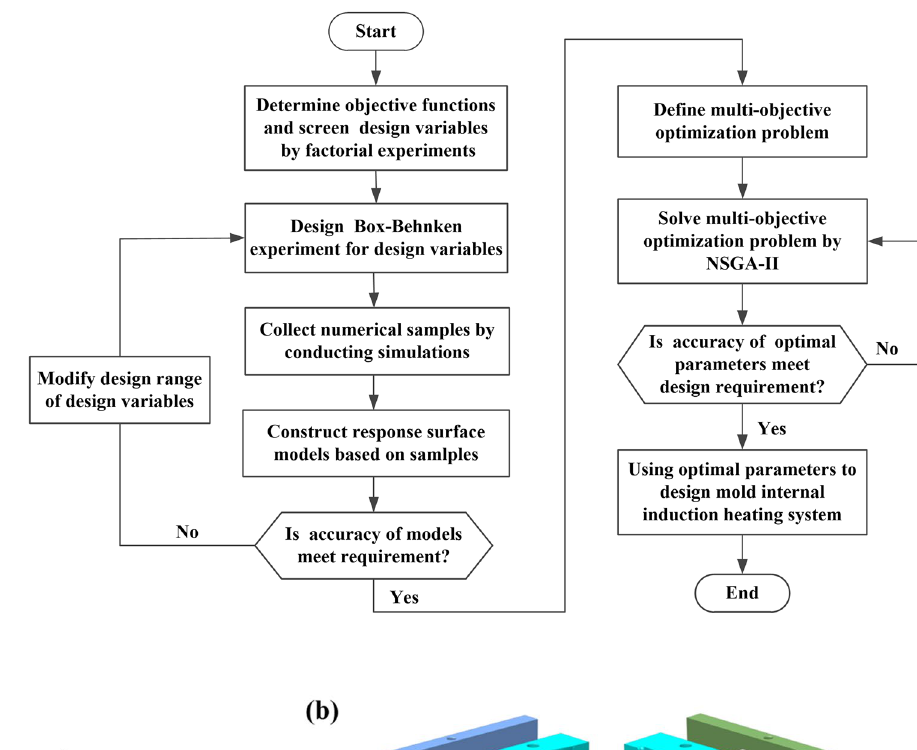
Fig. 7 Flow chart of optimiza- tion design for mold internal induction heating system